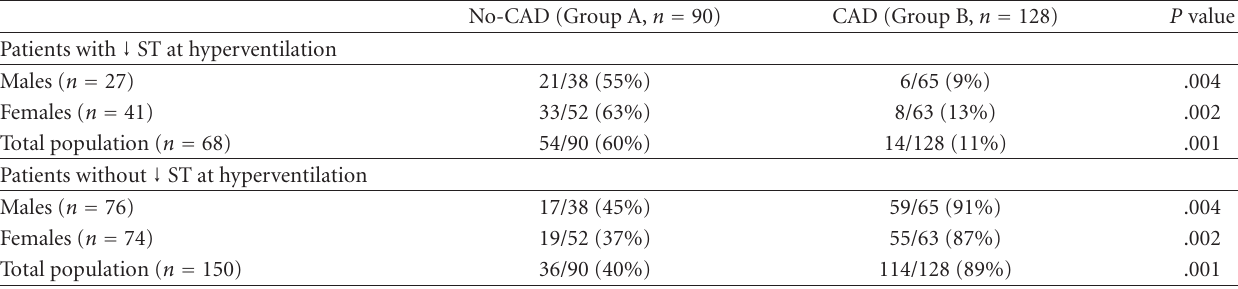
Table 3: Correlation of ST-segment depression at hyperventilation with angiographic